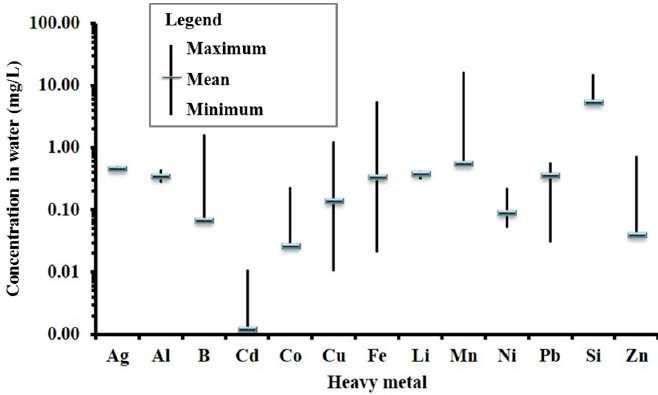
Figure 2. Concentration of heavy metals in water.